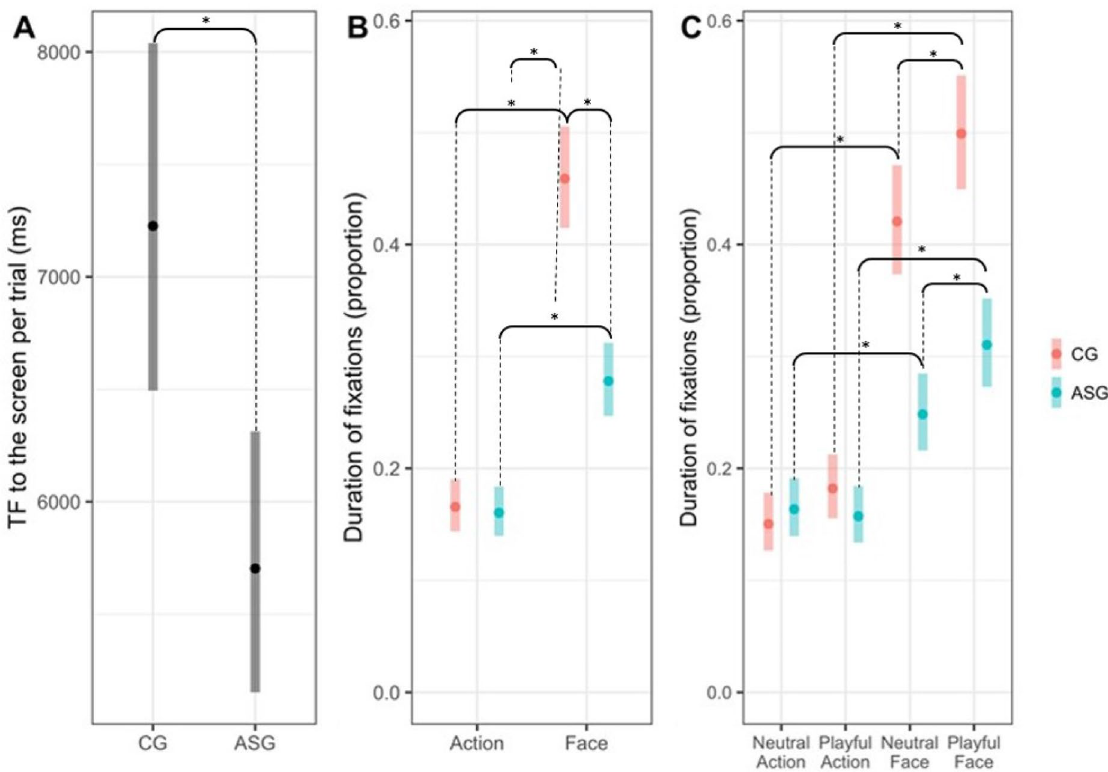
Figure 1. Results from the generalised linear mixed effect models (*= p < 0.05). Panel ( A ) shows the Total Fixations Duration (TF) per trial in CG and ASG estimated through a negative binomial mixed effect model. Panel ( B ) represents the proportion of fixations duration (P-FD) to the areas of interest (face, actions) in CG and ASG. Panel ( C ) represents the P-FD to the areas of interest across conditions (playful and neutral) in CG and ASG. Both results in panel B and C were obtained from a beta mixed effect regression model. Bars represent the 95% confidence intervals estimated by the regression